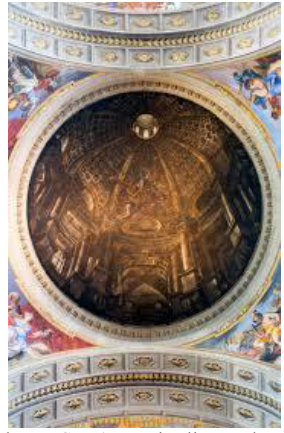
Fig. 13 False dome, Sant’Ignazio di Loyola, Rome (Andrea